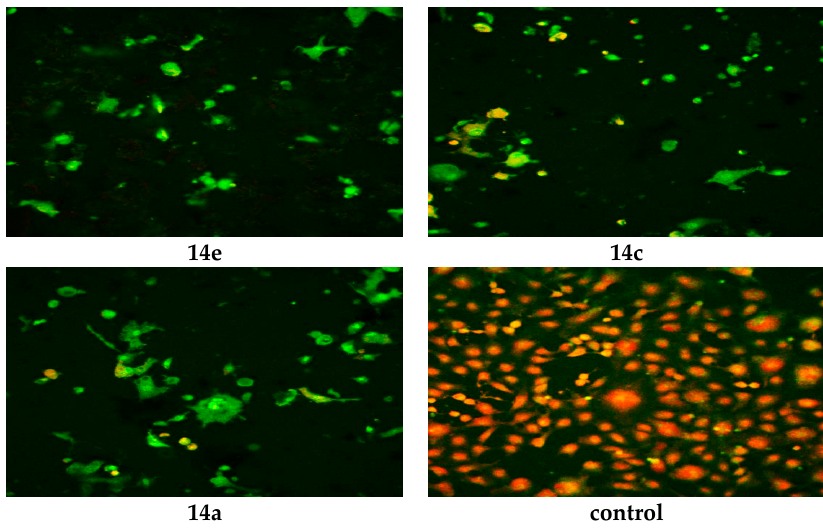
Figure 3. Confocal Laser Scanning Microscopy (CLSM) image of HEP G2 cell line treated with 0.6 μ M tested compounds ( 14e , 14c , 14a and untreated control). Stained by Acridine orange (green) and Rodamine 123 (Orange).